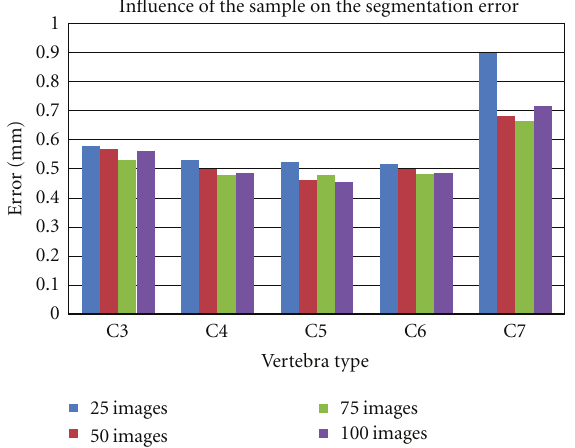
Figure 12: Influence of the sample size on the mean error of segmentation.